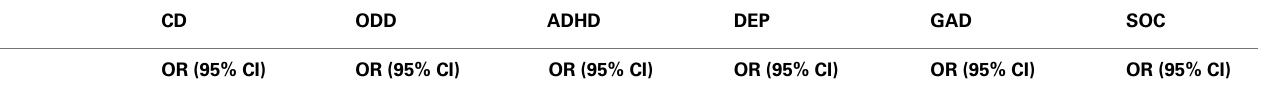
Table 2 | Unadjusted and adjusted pairwise comorbidity for common childhood diagnoses.